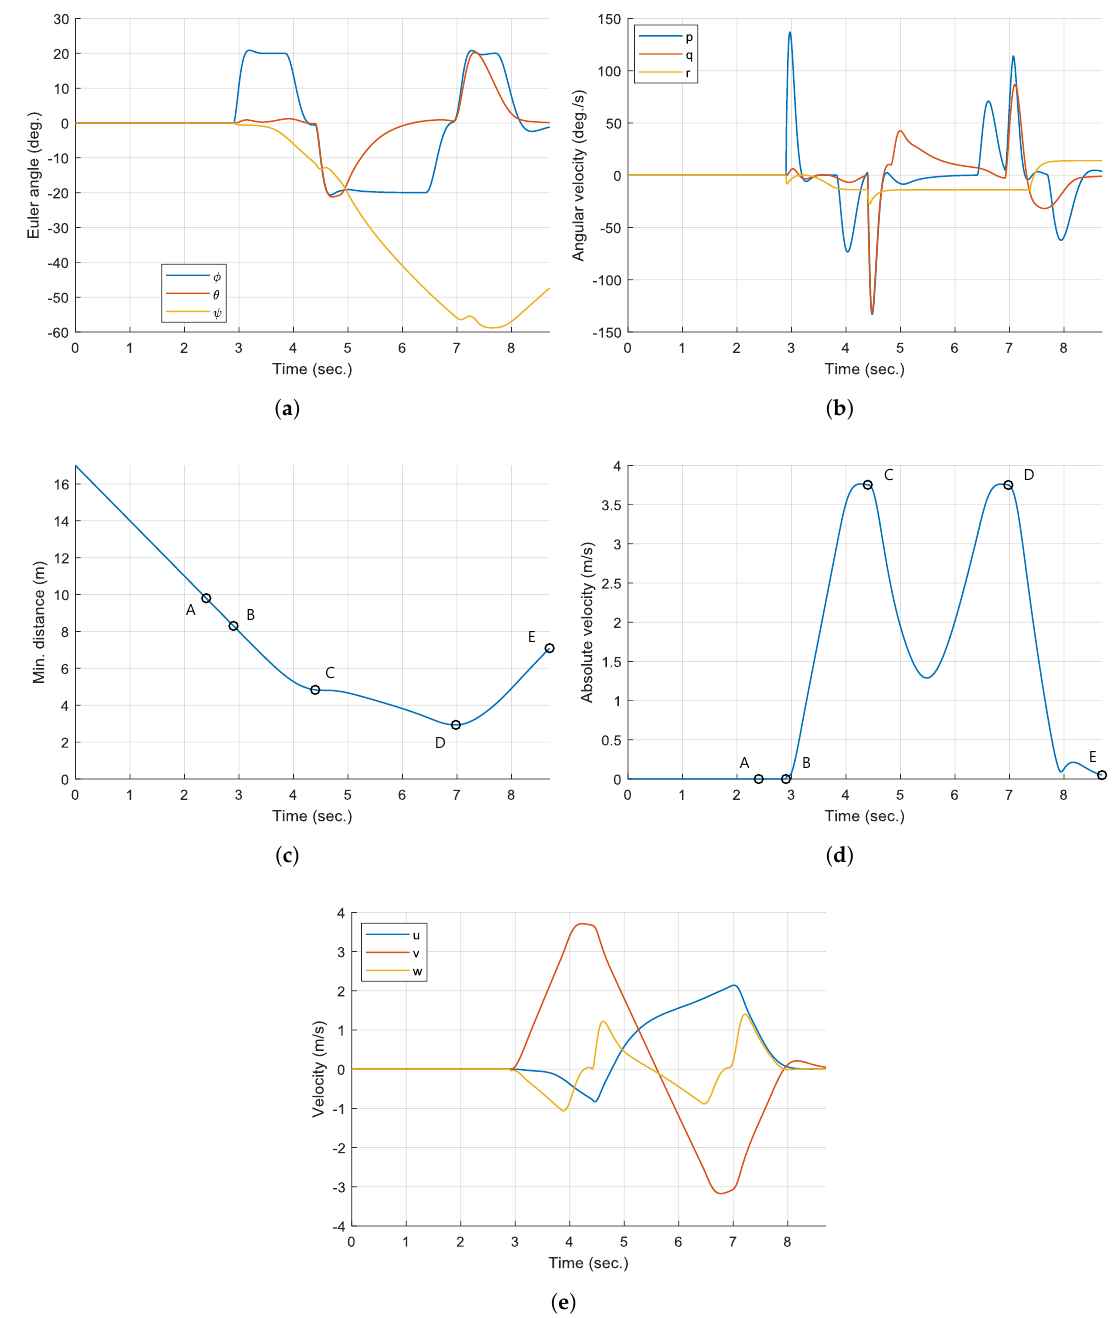
Figure 7. Time histories of UAV-related variables (Simulation I): ( a ) attitude, ( b ) body rate, ( c ) minimum distance between UAV and obstacle, ( d ) absolute velocity, and (e) velocity (body-fixed coordinate